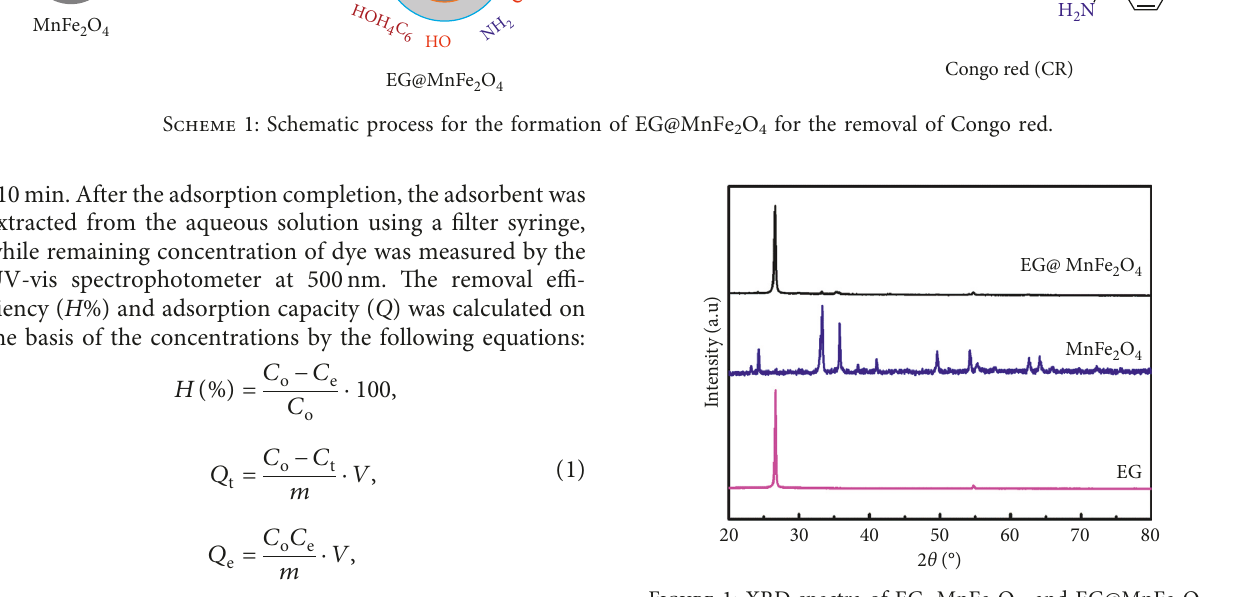
2 O 4, and EG@MnFe 2 O 4